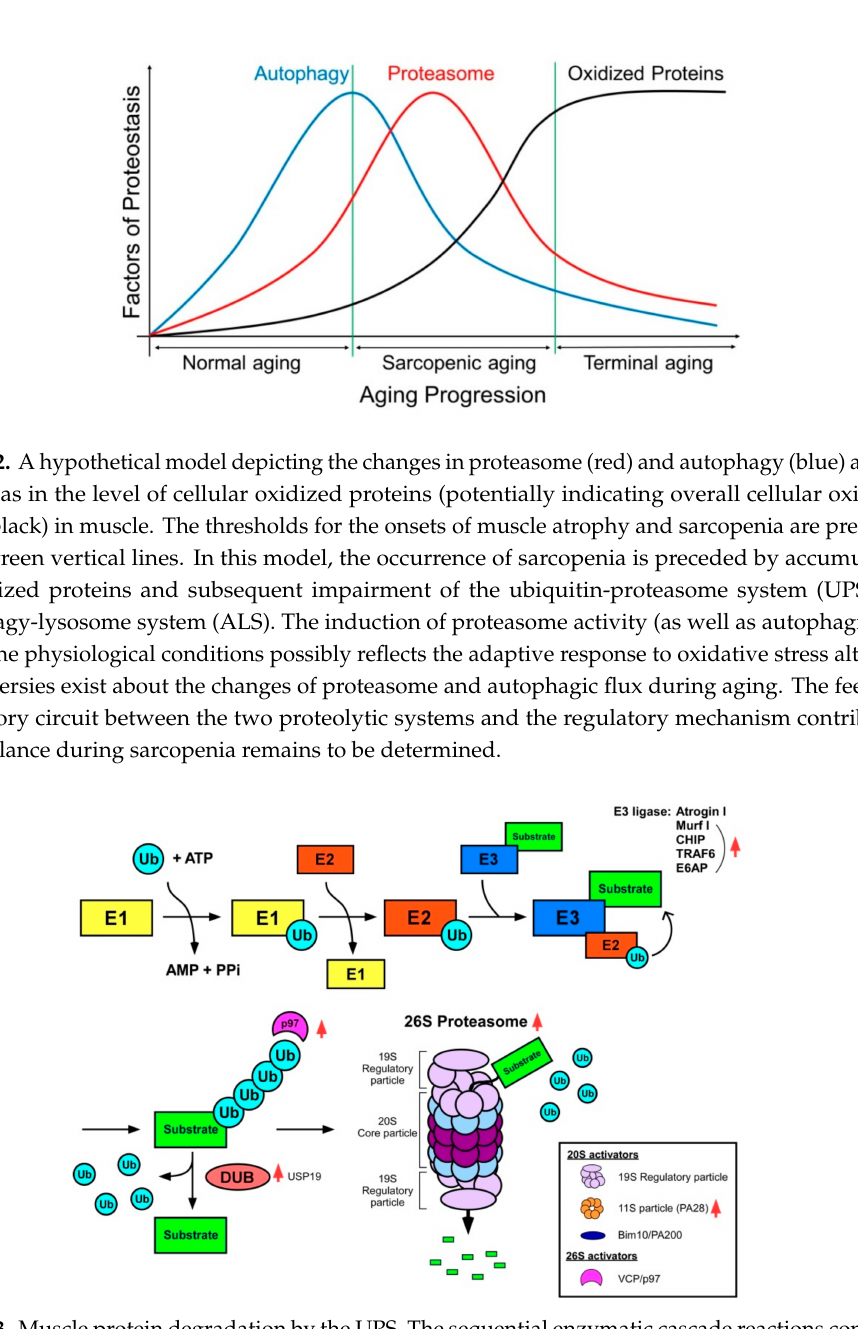
Figure 3. Muscle protein degradation by the UPS. The sequential enzymatic cascade reactions conjugate multiple ubiquitin moieties to the protein substrate. Polyubiquitylated substrates are either processed by deubiquitylating enzymes (DUBs) or degraded by the proteasome. The UPS components, such as ubiquitin ligases and proteasome regulators implicated in muscle atrophy, are shown. The increase in various components in ubiquitin–proteasome system is observed in sarcopenia, contributing to excessive and sustained protein degradation in skeletal muscle, shown in red